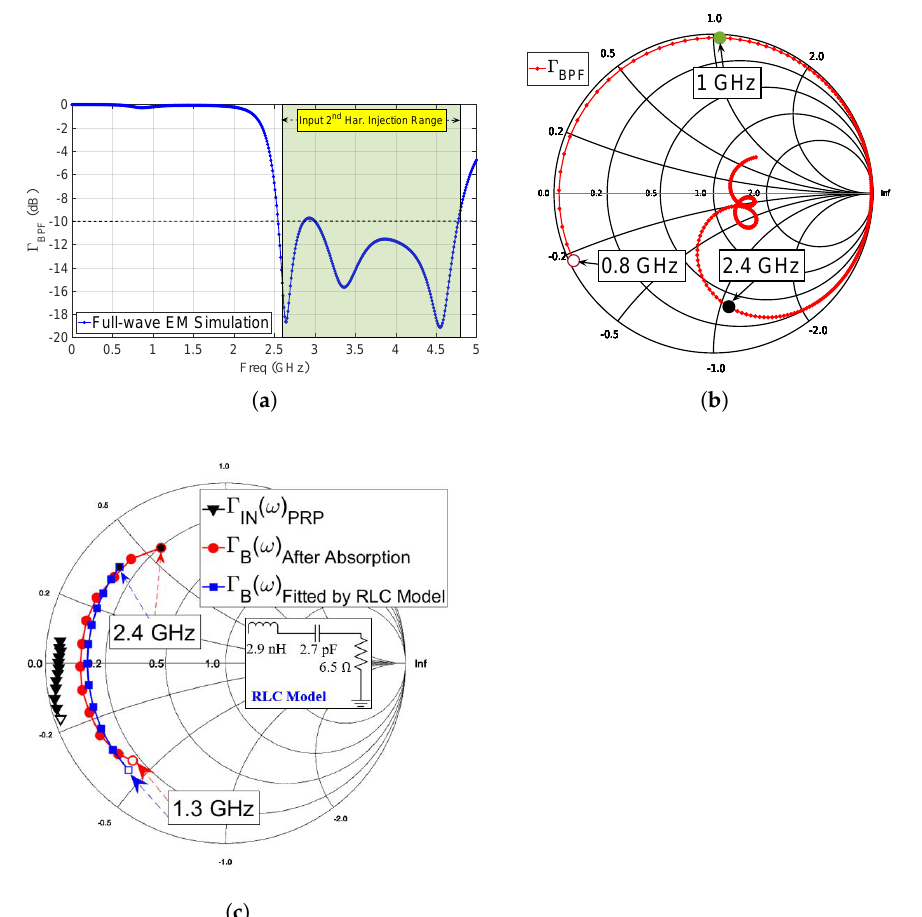
Figure 5. The design of the IMN diplexer with a broadband bandpass/bandstop filter for the input fundamental and second-harmonic signals, respectively, with: ( a ) the amplitude of designed Γ BPF from 0 to 5 GHz, ( b ) designed Γ BPF from 0.8 to 4.8 GHz, and ( c ) Γ IN ( ω ) , Γ B ( ω ) and the RLC model fitted as part of the input wideband matching network. Figure 6 shows the intrinsic loadlines at 2 GHz associated with the best (red) and worst (black) drain efficiencies with the corresponding active source impedances Z S ( 2 ω ) represented by the white triangles and circles in Figure 2. As is verified in Figure 6, the second-harmonic signal injected at the transistor’s gate is effectively tuning the intrinsic drain loadline at the CSRF. These simulations validate the low-power second-harmonic injection technique at the gate, which will be used experimentally in Section 3 to further optimize the drain efficiency. Note that in previously reported works [18–21], the second- harmonic signal was injected at the drain of the packaged transistor. The advantage of the broadband injection scheme proposed here is that less power is required since the second- harmonic signal is injected at the gate of the packaged transistor using an embedded broadband